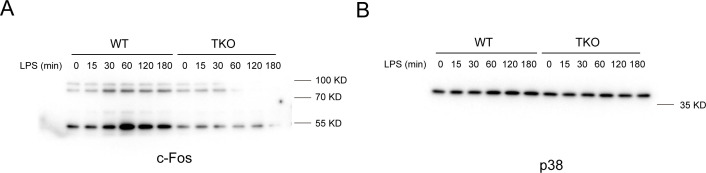
miR-17~92 family miRNAs sustain Fos expression in TKO BMDMs.(A and B) The whole immunoblots of c-Fos (A) and p38 (B) in whole-cell lysates of WT and TKO BMDMs treated for the indicated periods with LPS.